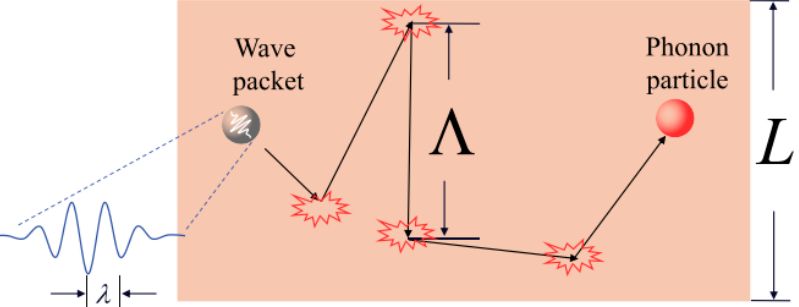
Figure 3. The schematic for the phonon particle picture [44]. Reprinted with permission from ref. [44]. Elsevier and Copyright Clearance Center.